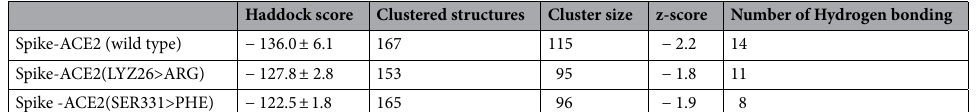
Haddock score Clustered structures Cluster size z-score Number of Hydrogen